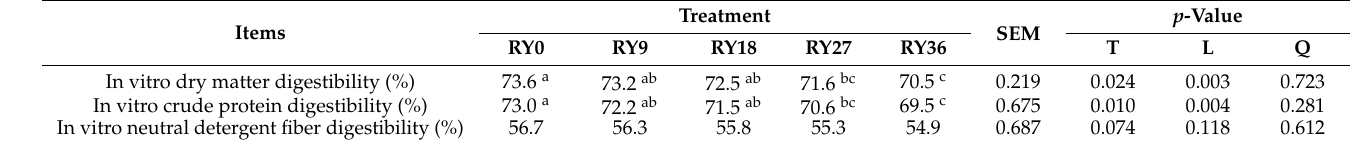
Table 8. Effect of paper mulberry replacement levels on in vitro digestibility of 56-day TMR silages.